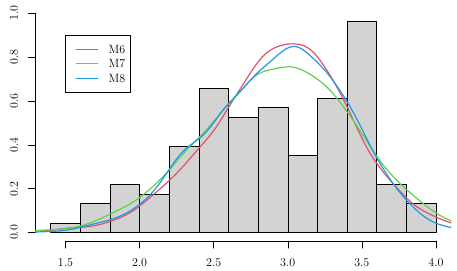
Figure 9 – Histogram of the Canadian lynx time series and the non-parametric kernel density estimation of 10000-length simulated trajectories from the TARMA models M6 –